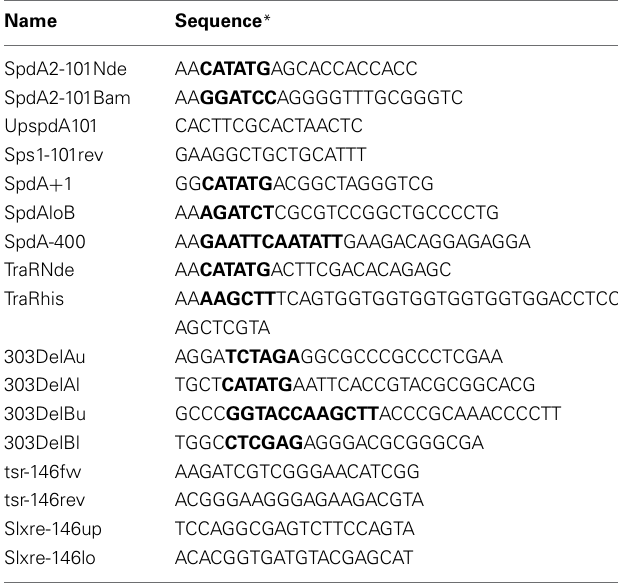
Table 2 | Oligonucleotid primer used in this